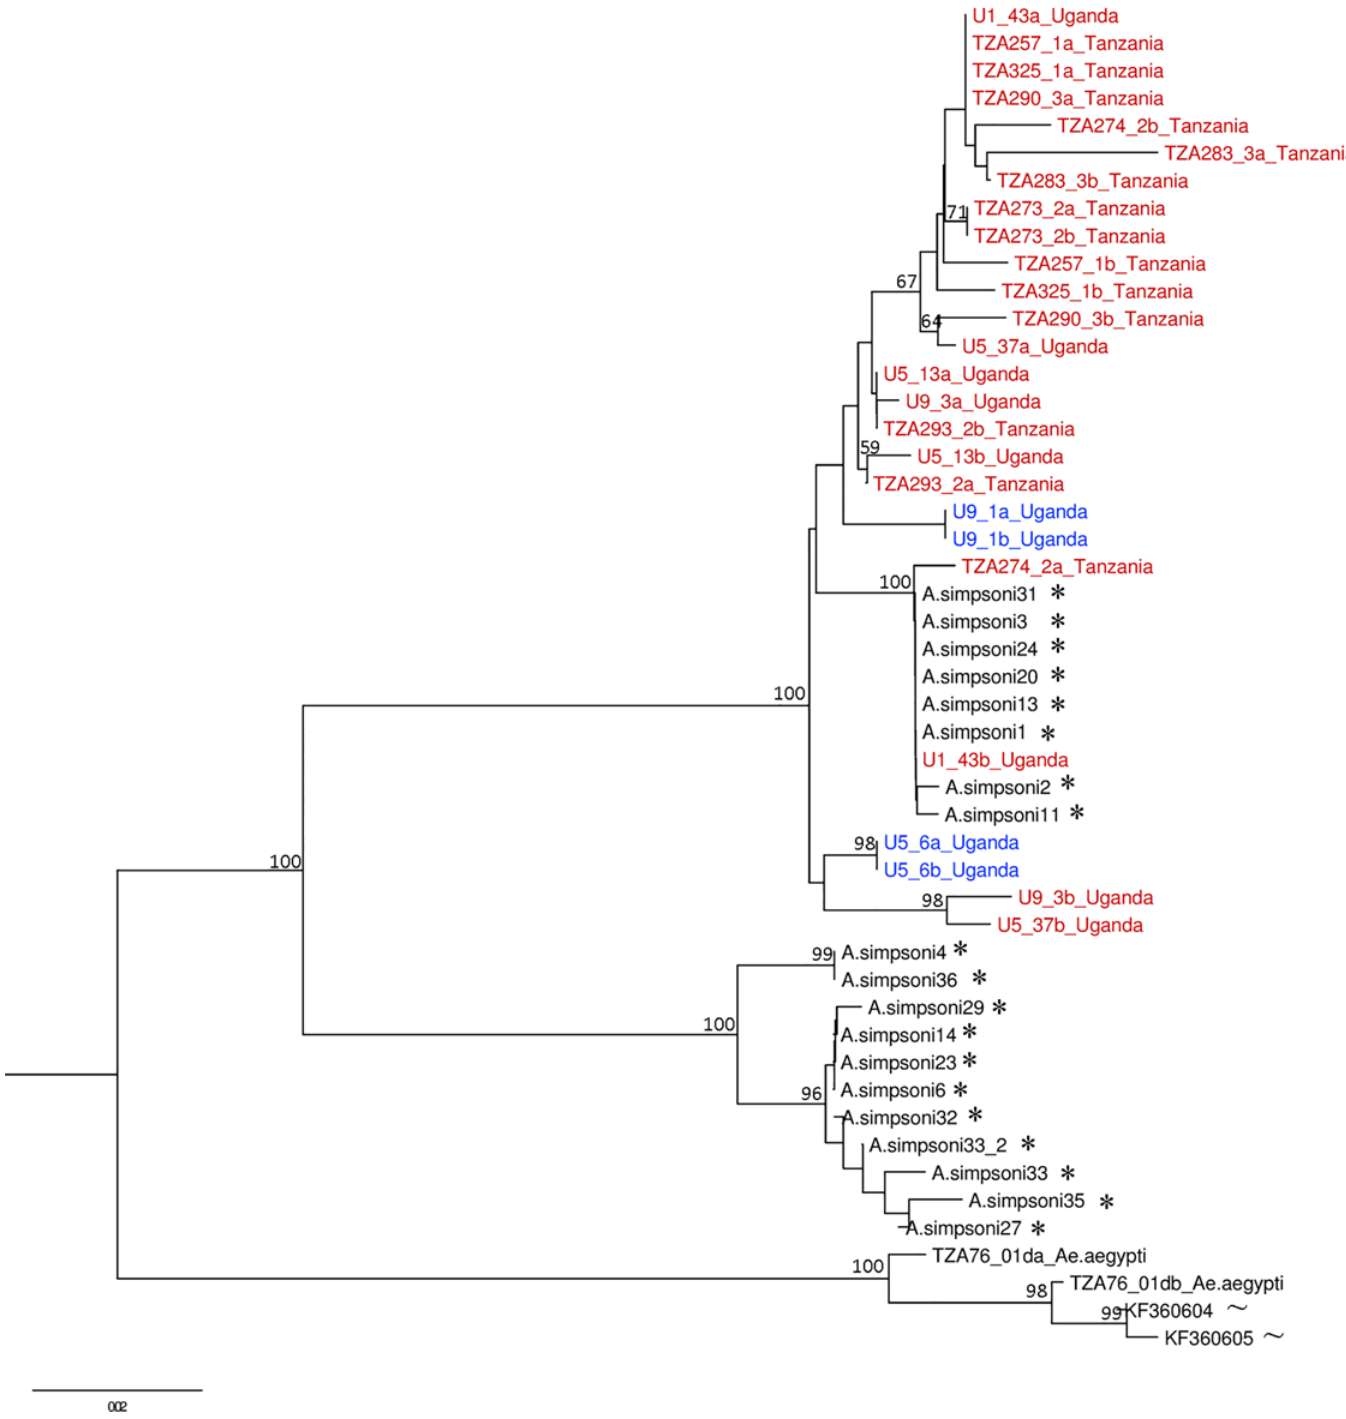
Fig 4. Neighbour joining tree of CYPJ92 sequence data with labels coloured according to ITS -based species designation. Red labels represent Ae . bromeliae while blue labels are Ae . lilii . Sequences from Walter et al . [28] ( * ) and Ae . aegypti outgroups (~) from Brown et al . [47] are annotated. Bootstrap support values for branches above 55% are